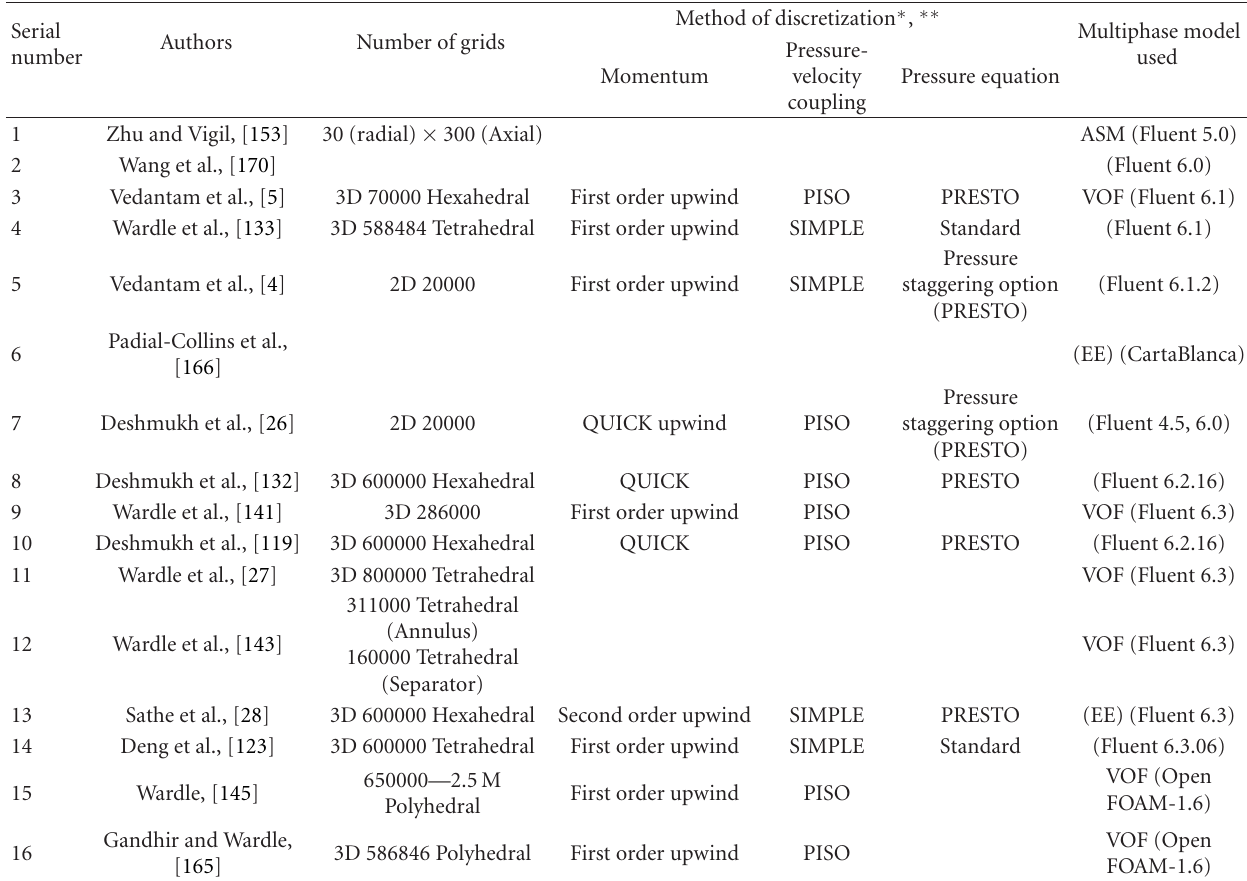
Table 2: Some details of CFD simulations in previous